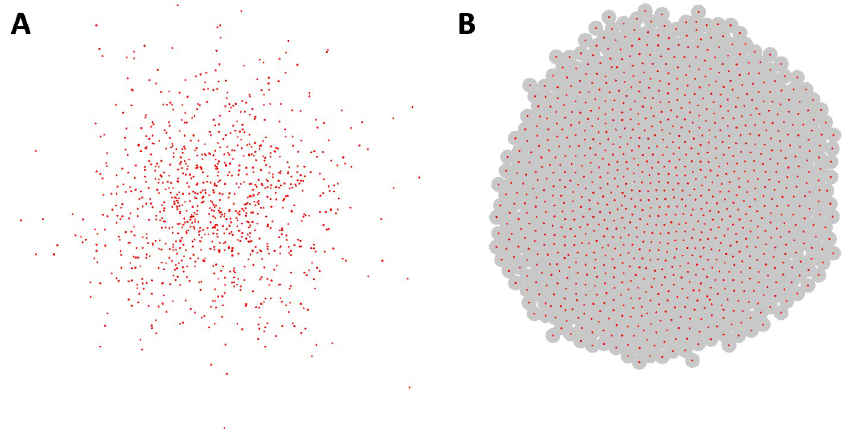
Fig 2. Off-lattice agent examples. Each example contains 1000 agents. (A) Example of 2D Point Agents modeling Brownian motion. The Point Agents move freely and cannot collide. (B) Example of 2D Spherical Agents modeling a growing cell colony. The agents will push apart from each other to a uniform density. Agent radii are shown as gray circles around their centers. Examples Displayed using the OpenGL2DWindow object.